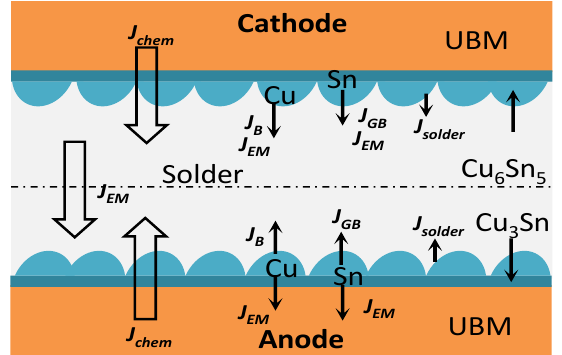
Figure 8. Atom Figure 8. Atom migration.